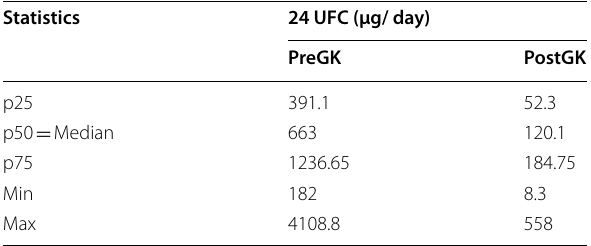
Table 5 Pre- and post-radiosurgery 24 UFC hormonal